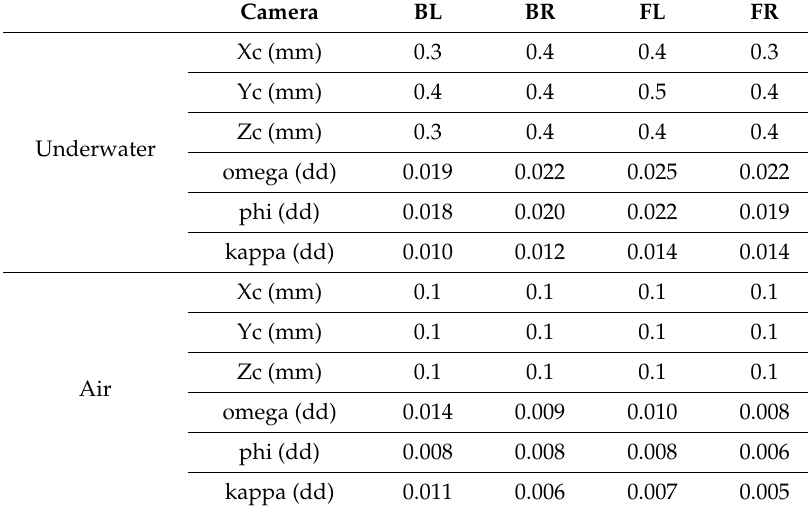
Table 8. Mean EOP precision of all cameras underwater and in-air when applying the CMB